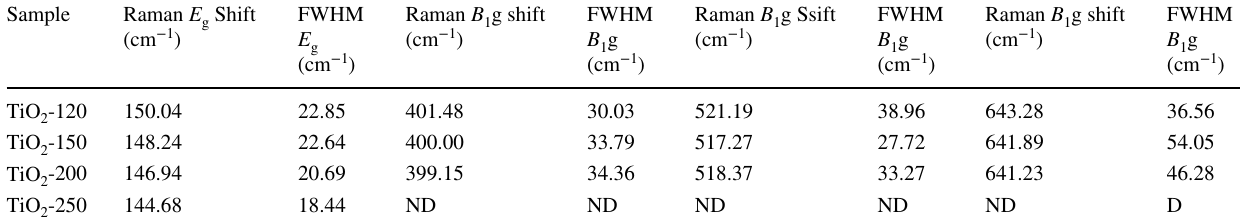
Table 1 Raman displacements of mesoporous TiO Sample